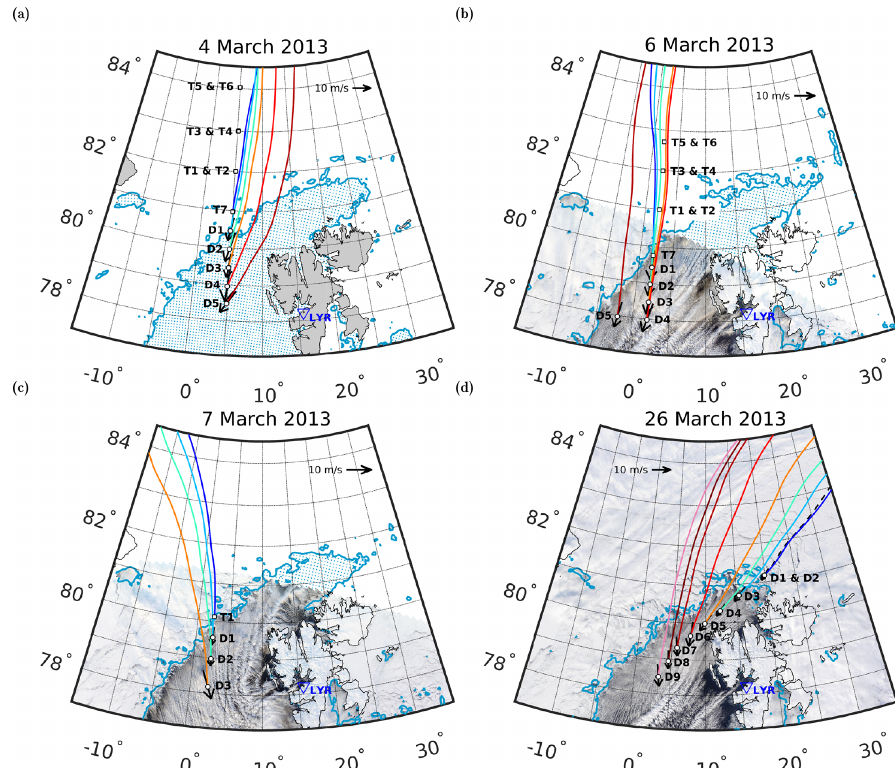
Figure 1. Ice edge based on a 70% threshold value of the ice concentration (derived with the Arctic Radiation and Turbulence Interaction Study, ARTIST, Sea Ice algorithm for the Advanced Microwave Scanning Radiometer 2; see Spreen et al., 2008) during MCAOs on (a) 4 March, (b) 6 March, (c) 7 March, and (d) 26 March 2013. The arrows denote the vertically ABL-averaged wind at the positions of the dropsondes listed in Table 2. In panels (a) – (c) , locations of the aircraft profiles listed in Table 1 are shown. Coloured lines are backward trajectories obtained with the Hybrid Single-Particle Lagrangian Integrated Trajectory transport and dispersion model (Draxler and Rolph, 2010) at 10m height from the positions of the dropsondes and of the southernmost aircraft vertical profiles for 4, 6, and 7 March. The backgrounds of panels (b) – (d) are the corresponding MODIS visible images at 13:10, 12:15, and 12:45UTC respectively (data from https: //lance.modaps.eosdis.nasa.gov/modis/, last access: 16 August 2021). Blue triangles mark the location of Longyearbyen airport (LYR). Modified based on Tetzlaff et al. (2014) and Tetzlaff